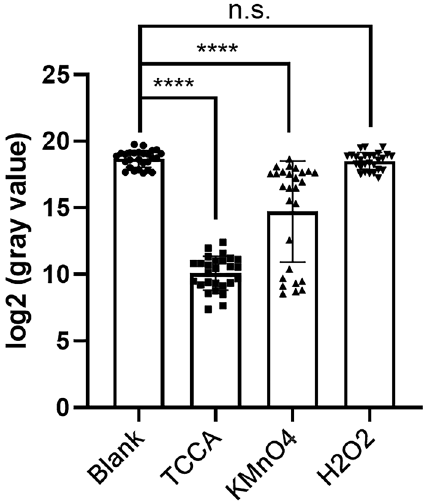
Figure 1. Gray values of 27 cases of tissues with high melanin content bleached by different oxidants for 15 min. The ordinate is the gray value converted by log, and the horizontal coordinate is the name of